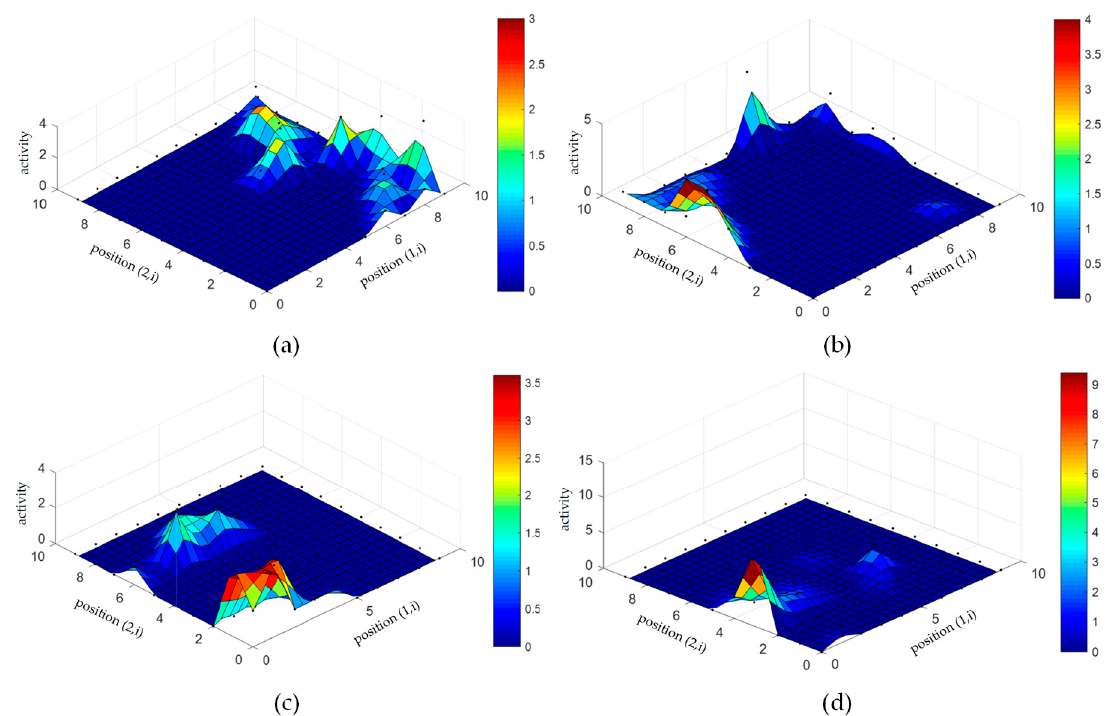
Figure 19. Active areas of 10 × 10 SOM map in the case of healthy bearing ( a ), damage to outer raceway ( b ), inner raceway ( c ), rolling element ( d ) for the neighbourhood radius equal to 2 and the linkdist distance function.